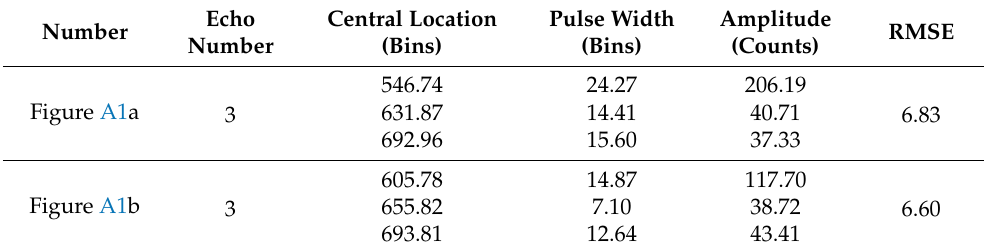
Table 1. FPGA terrestrial LiDAR echo decomposition results.